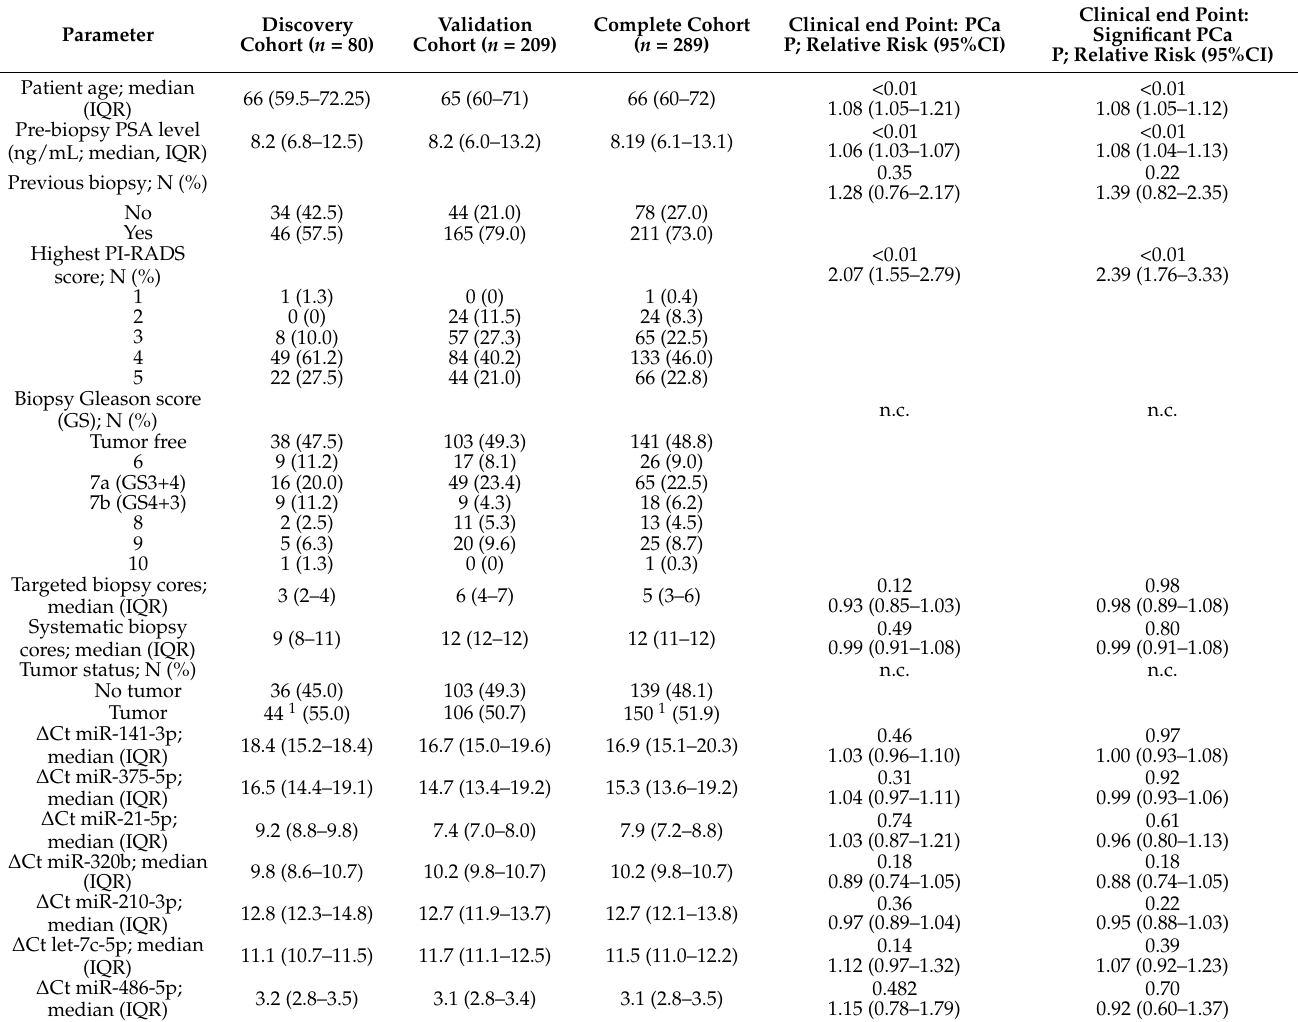
Table 1. Patients’ characteristics and univariate association of individual variables with clinical end